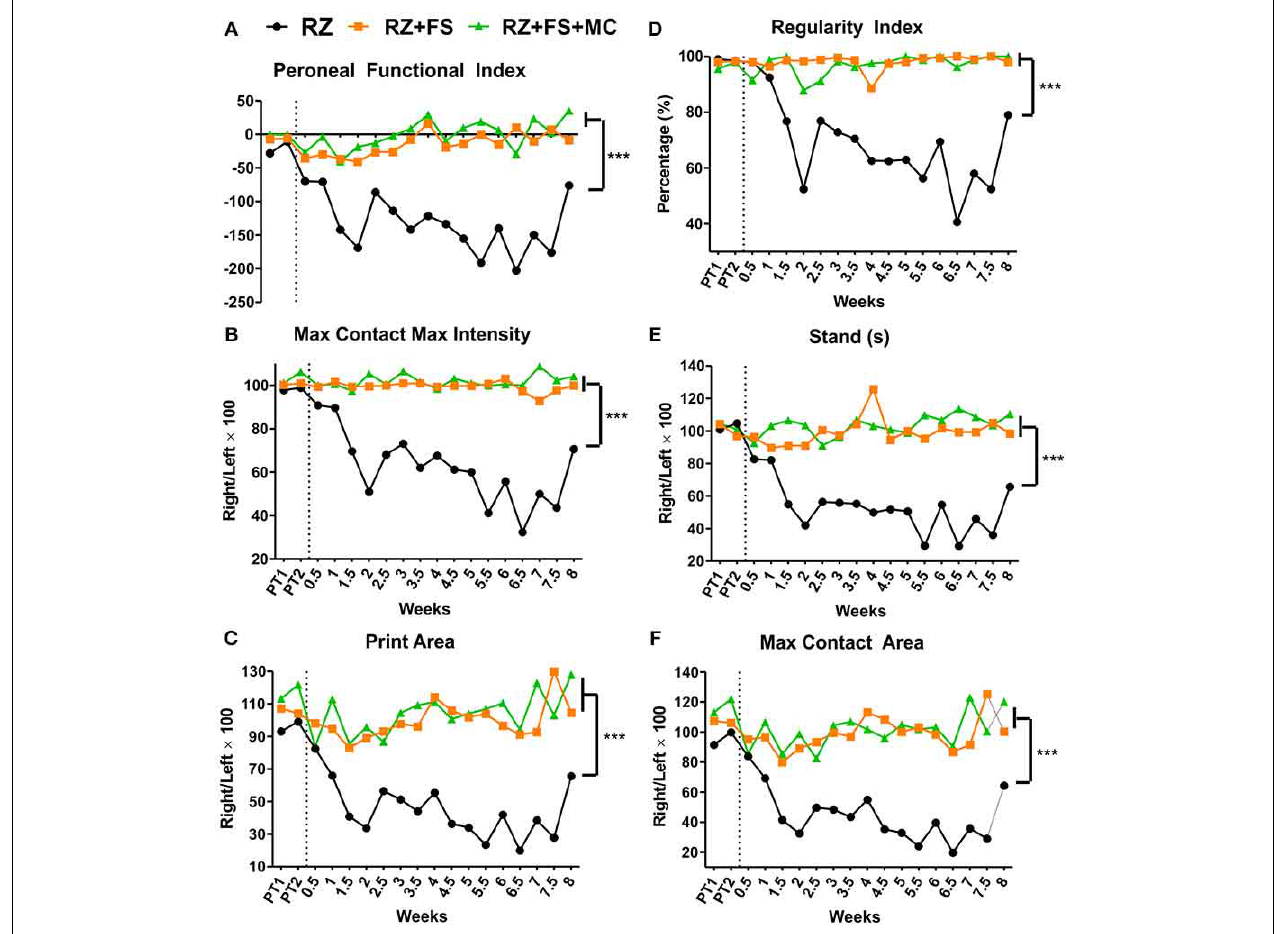
FIGURE 2 | Walking track test carried out using the Catwalk system (Noldus Inc., Holland). (A) Peroneal functional index. (B) Max contact max intensity. (C) Print area. (D) Regularity index. (E) Stand (time in seconds that the animal stood over the paw